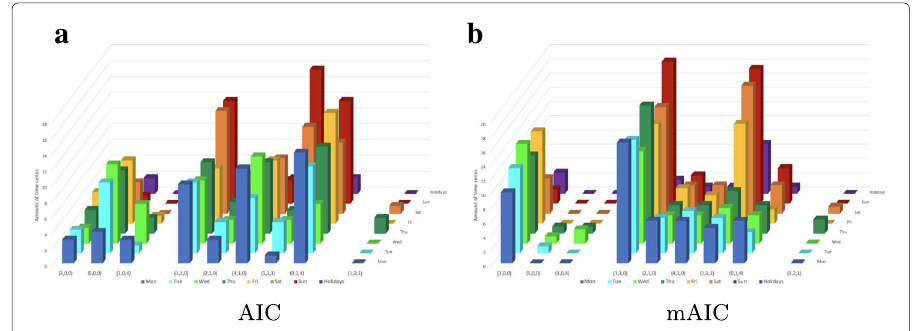
Fig. 12 Amount of time series per cluster for hydro pumped storage a AIC. b